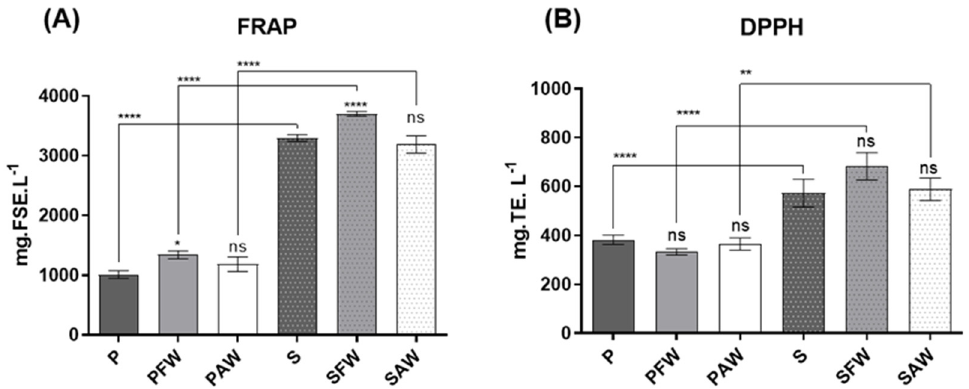
Figure 1. Antioxidant activity assessment through the FRAP ( A )—expressed in mg of ferrous sulphate equivalents per litre of beer sample (mg FSE · L − 1 ), and DPPH ( B )—assays presented in mg of Trolox equivalents per litre of beer sample (mg TE · L − 1 ). Significant differences are indicated over the bars (compared to the respective P and S controls) and over the brackets (comparing the same treatments with different woods). **** Significant at p < 0.0001, ** significant at p < 0.01, and * significant at p < 0.05. ns: not significant. Values expressed as mean ± SEM (n = 3).